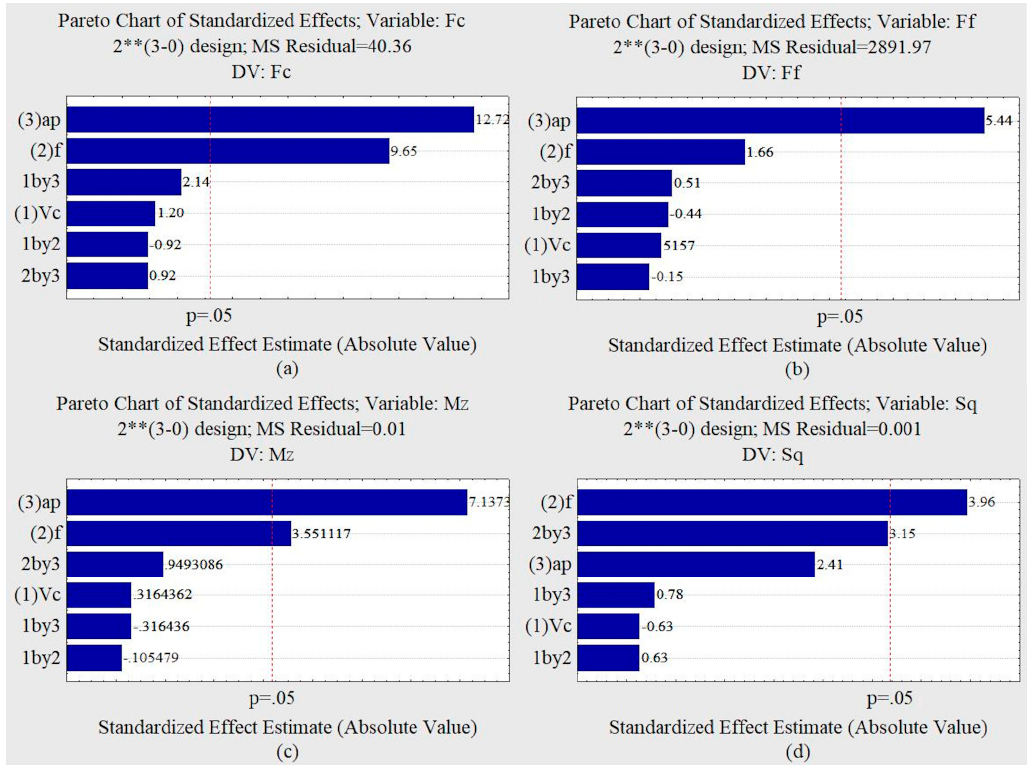
Figure 16. Pareto graphs for machining condition with graphite. ( a ) Cutting force F c . ( b ) Feed force F f . ( c ) Torque M z . ( d ) Roughness S q .